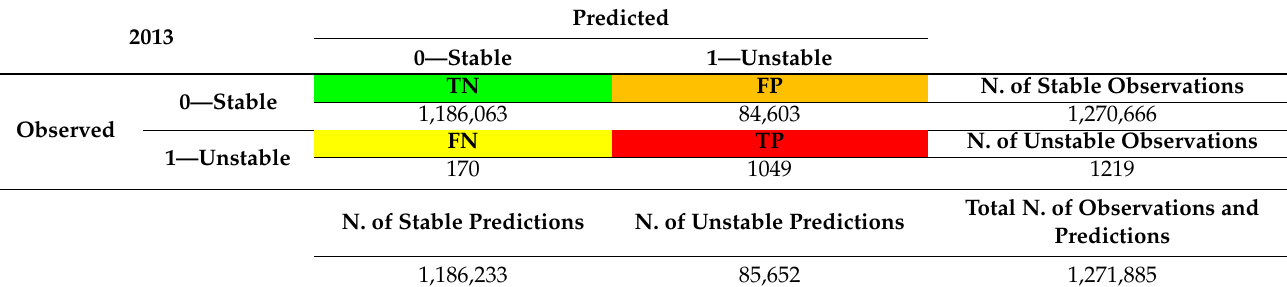
Table 5. Number of correct and false predictions resulting from TRIGRS simulations for the 2013 event.